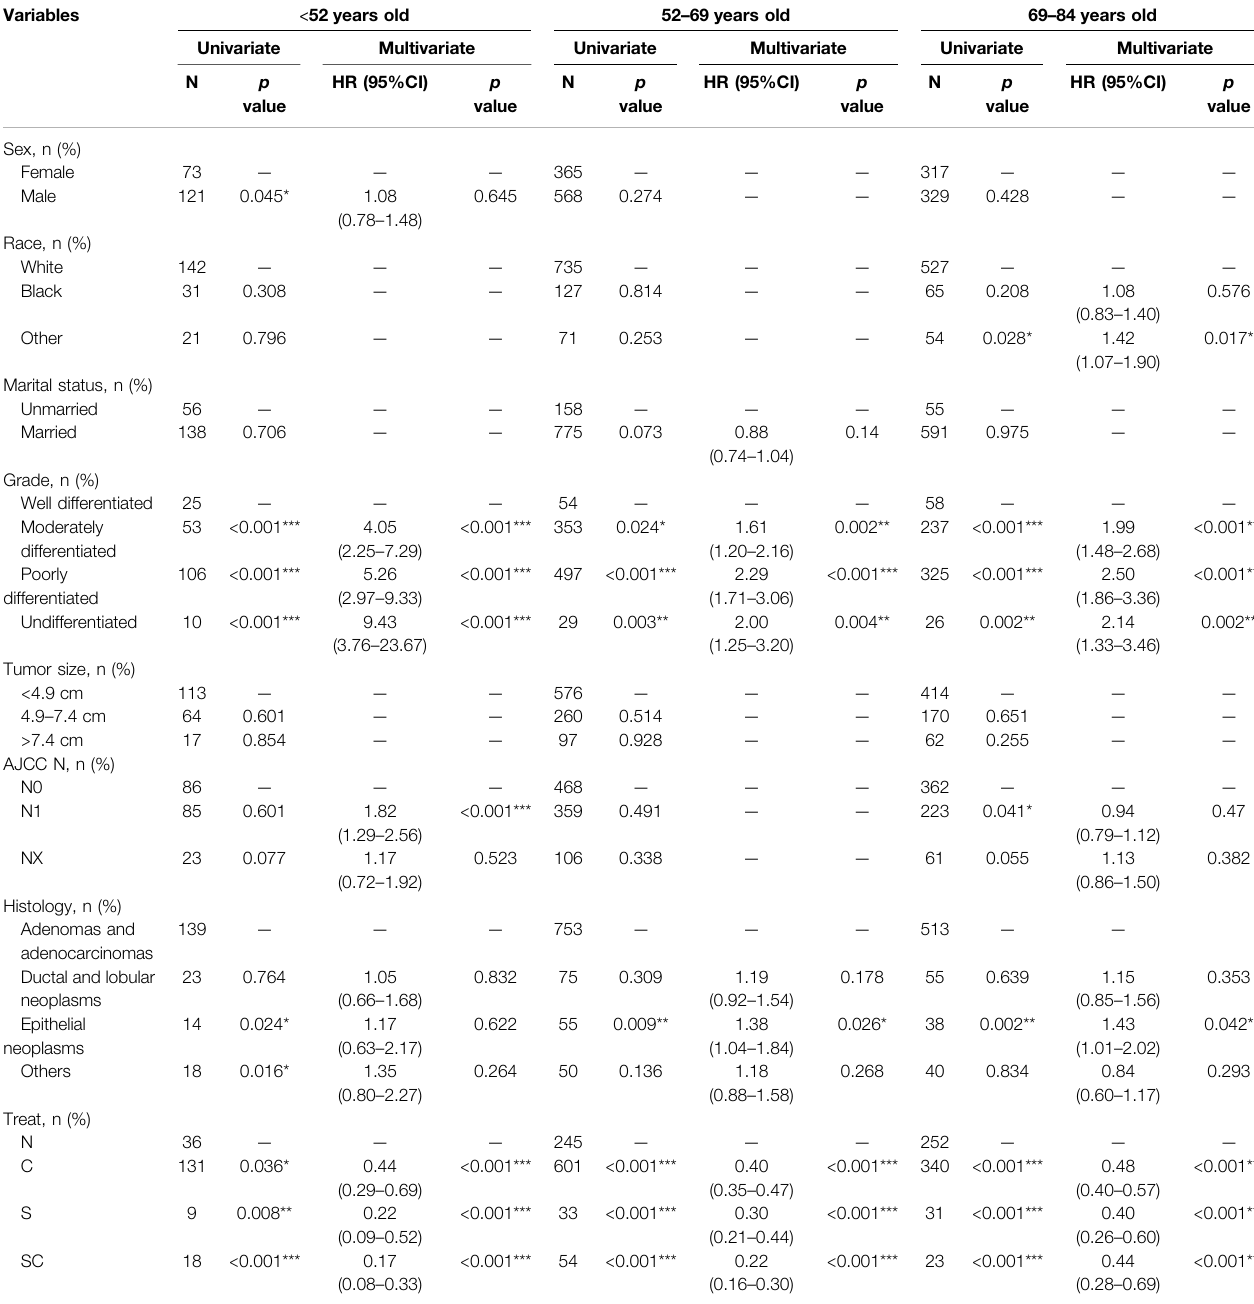
TABLE 4 | Univariate and multivariate of CSS in the patients with pancreatic cancer metastasis to liver grouped by age at diagnosis. Variables < 52 years old 52 – 69 years old 69 – 84 years old Univariate Multivariate Univariate Multivariate Univariate Multivariate